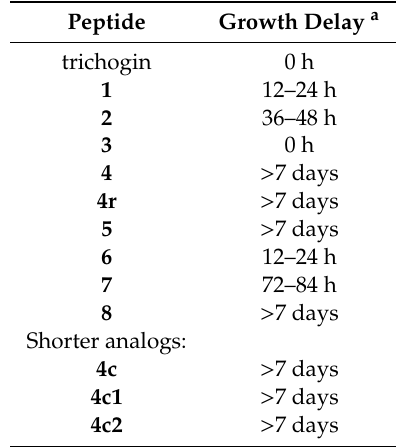
Table 2. Inhibition of growth of B. cinerea in microtiter wells containing potato dextrose broth (PDB) medium after treatment with peptides at 15 µ M.